Question: How would you classify this visualization?
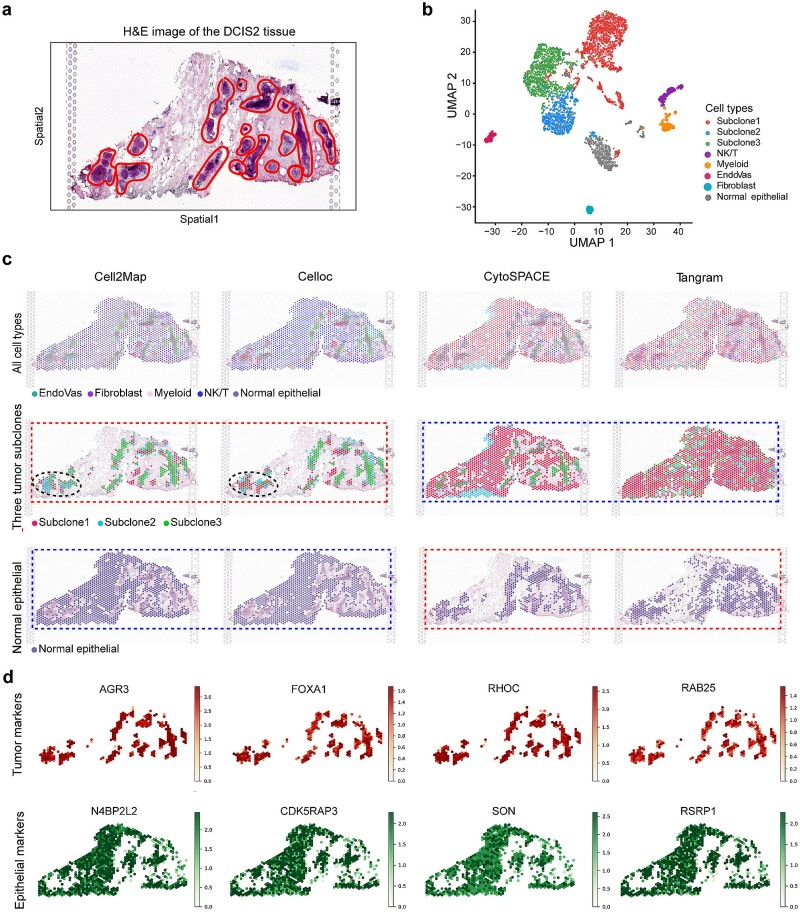
Answer: scatter